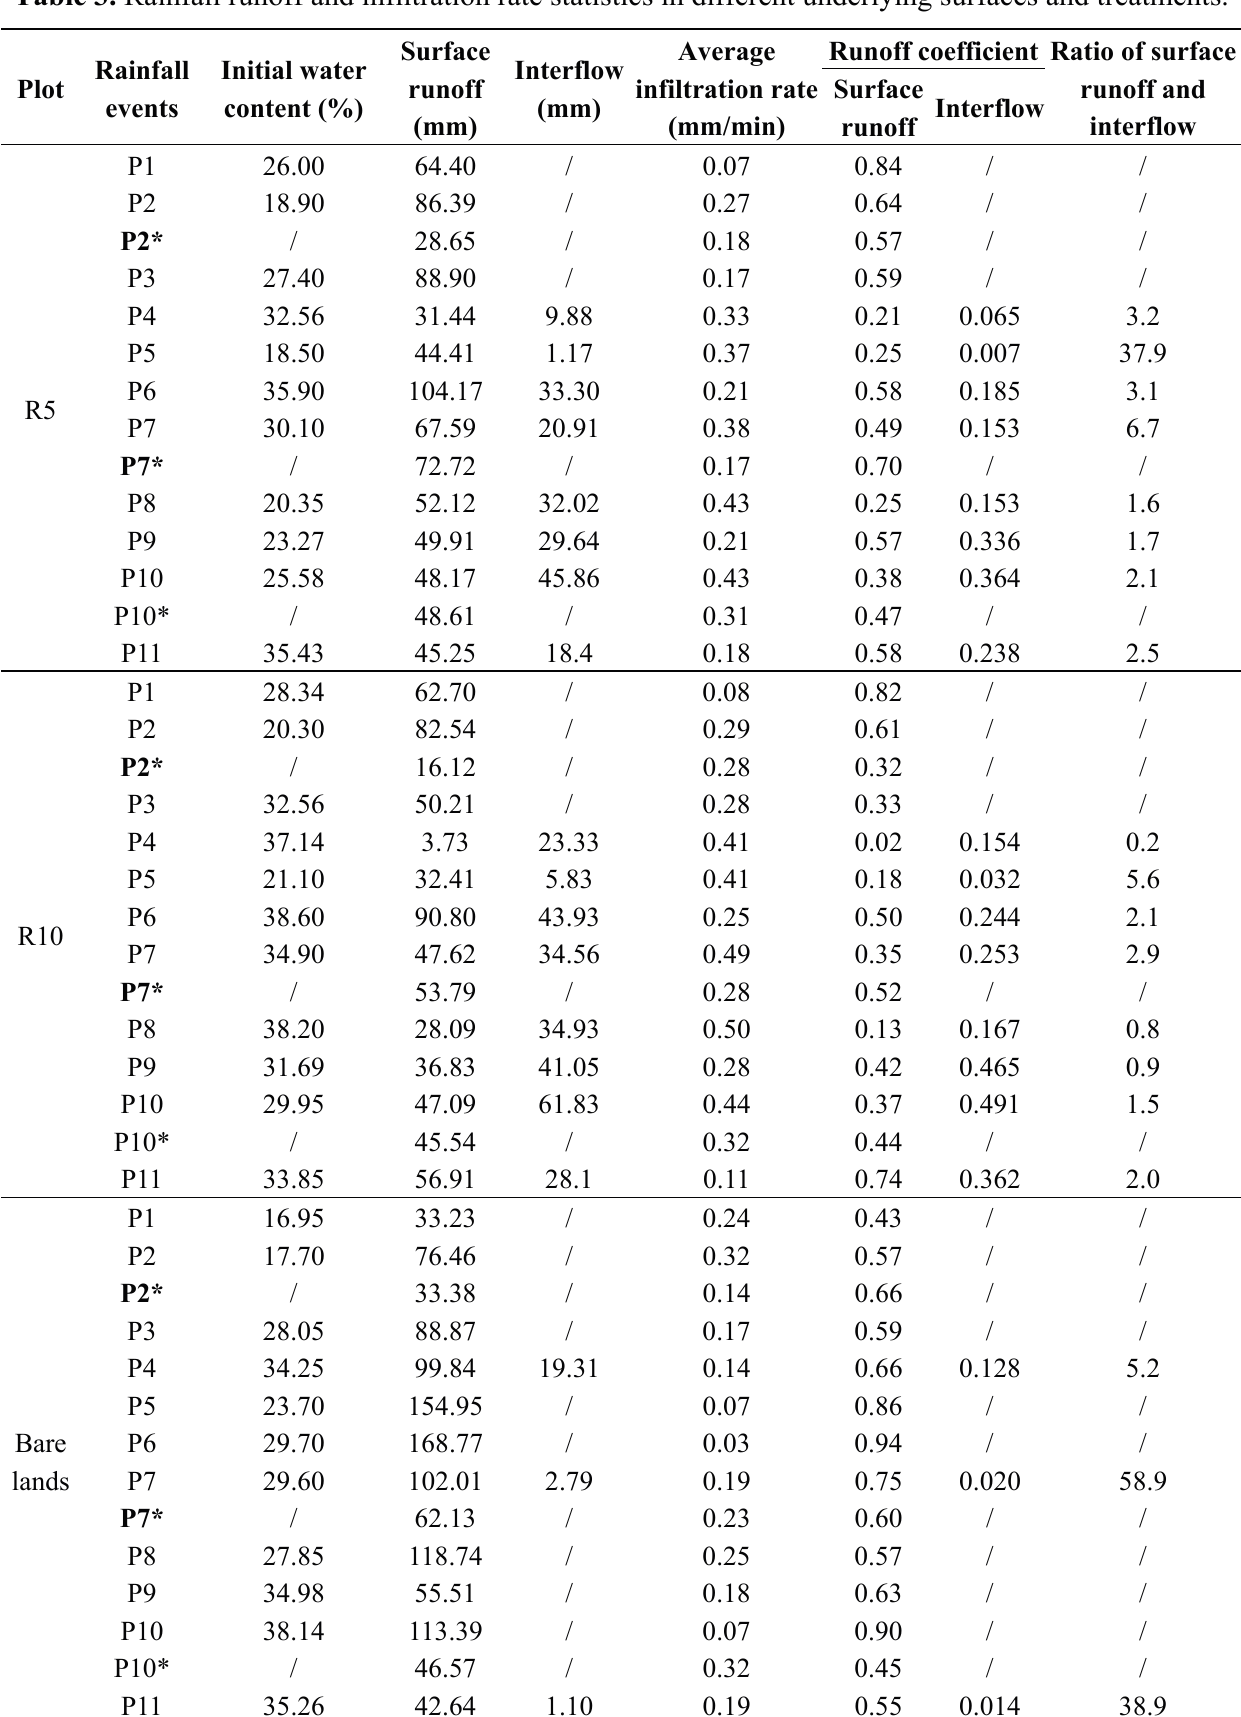
Table 3. Rainfall runoff and infiltration rate statistics in different underlying surfaces and treatments.